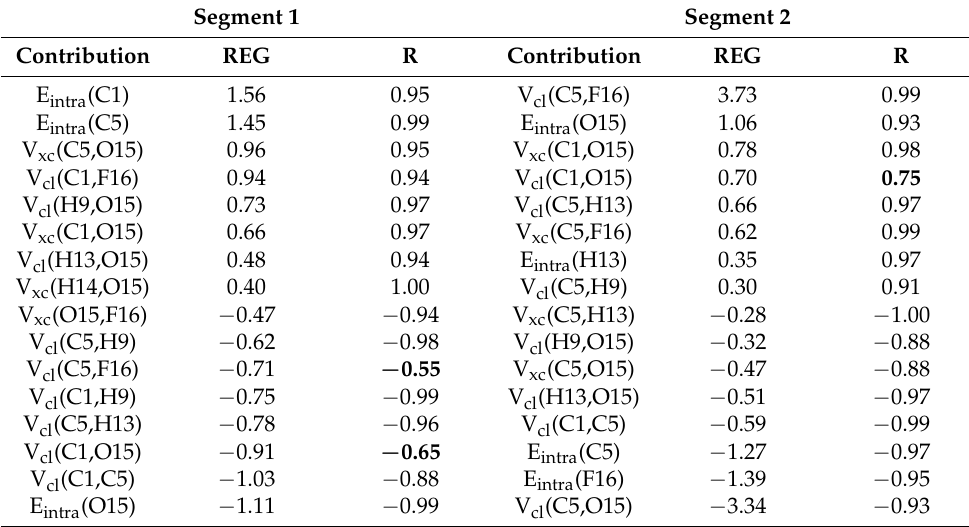
Table 5. REG analysis for the S isomer. Unacceptably low R values are marked in bold. Segment 1 Segment 2 Contribution REG R